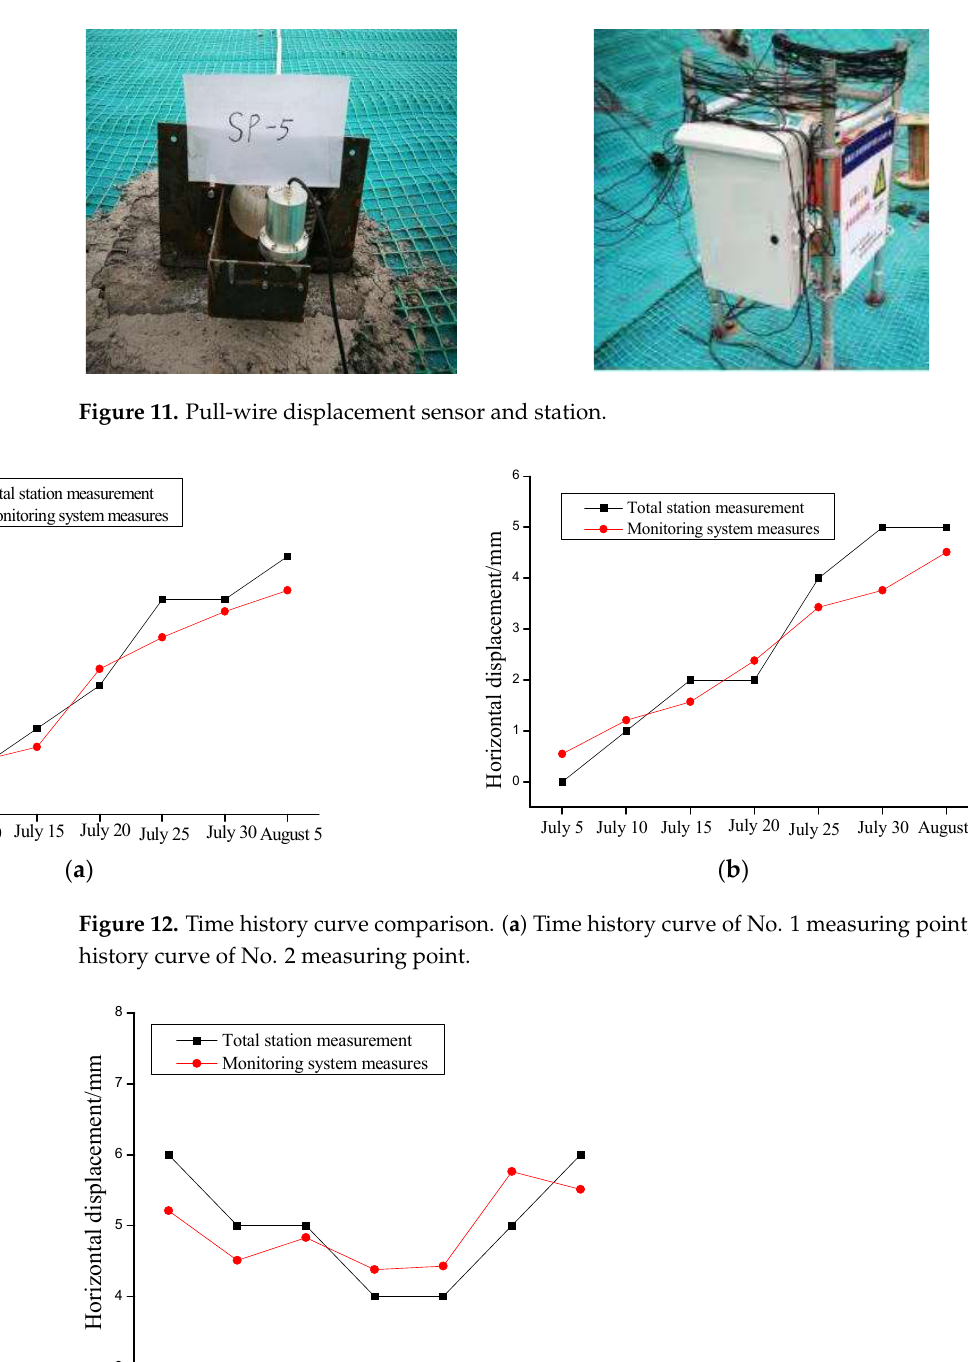
8 of 10 Figure 10. Layout of measuring points for slope horizontal displacement.